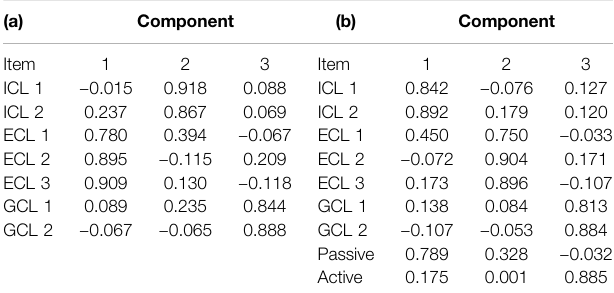
TABLE 2 | Rotated PCA (a) with items from Klepsch et al. (2017) and (b) including the passive and active items for study 1.